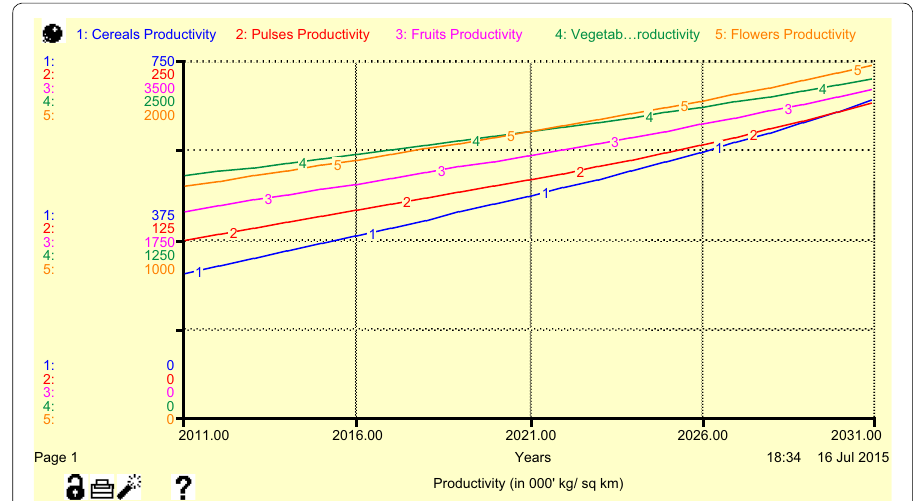
Fig. 13 Projected production of cereals, pulses, fruits, vegetables, and flowers up to year 2031